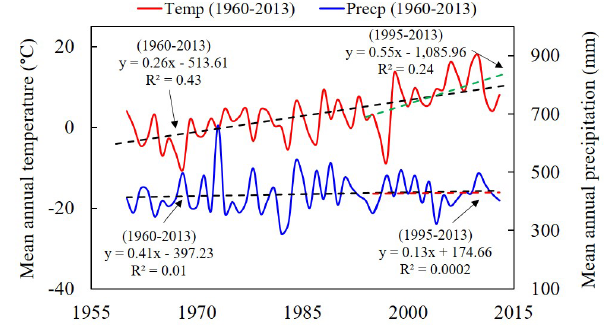
Figure 14. Trends in mean annual temperature ( ◦ C) and precipi- tation (mm) between 1960 and 2013 in the CCW based on Pagri Meteorological Station (PMS). Data source: http://www.cru.uea.ac. uk/data (last access: 13 June